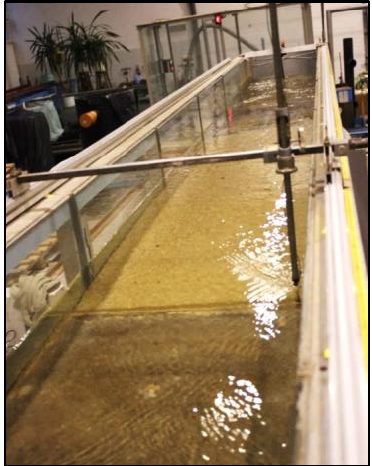
Figure 6. Variant I of the flume development.